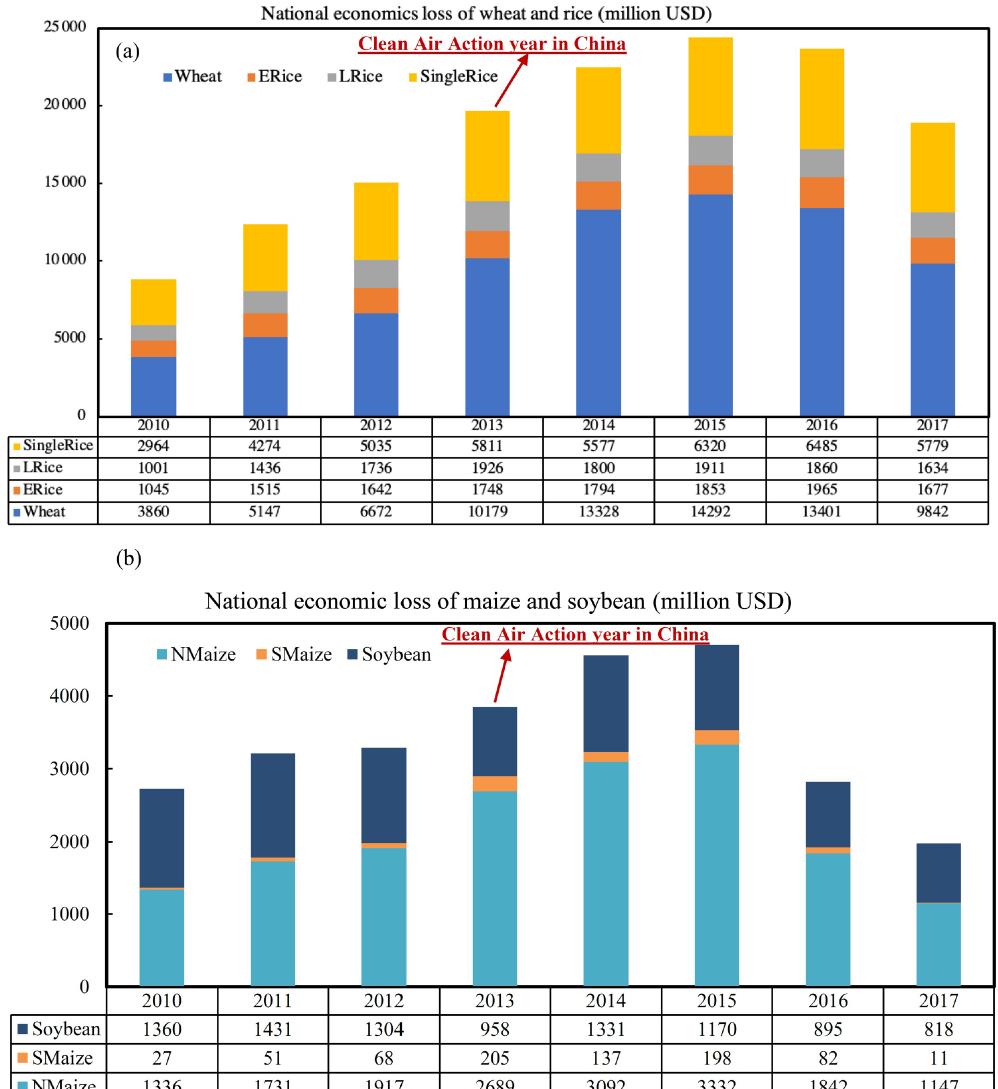
Figure 8. National economic loss from crop production loss from (a) wheat and rice (double early and late rice, single rice) and from (b) maize (north maize and south maize) and soybean from 2010 to 2017. The units are million